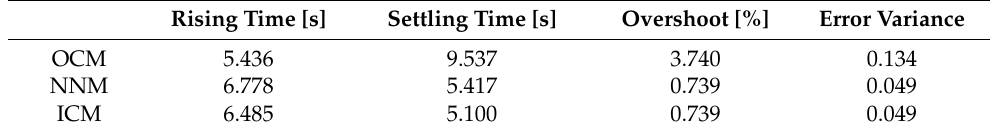
Table 5. Tracking performance indexes of three control